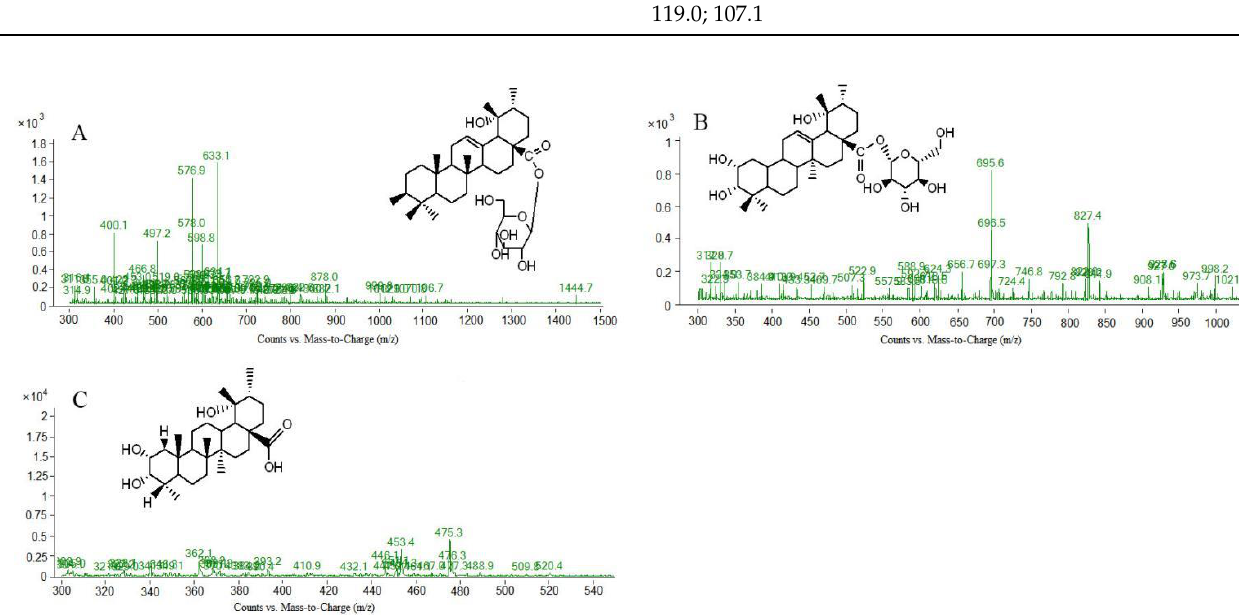
Figure 3. Mass spectrum and structure of disappeared components in Sanguisorba officinalis L. after processing. A : 3β, l9α -dihydroxyursin-12-en-28-acid- β -D-glucose ester; B : 2α,3α,19α -trihy- droxyurs-12-en-28-acid- β -D-glucopyranosyl ester or isomer; C : 2α,3α,19α -trihydroxyurs-12-en-28- oic-acid.